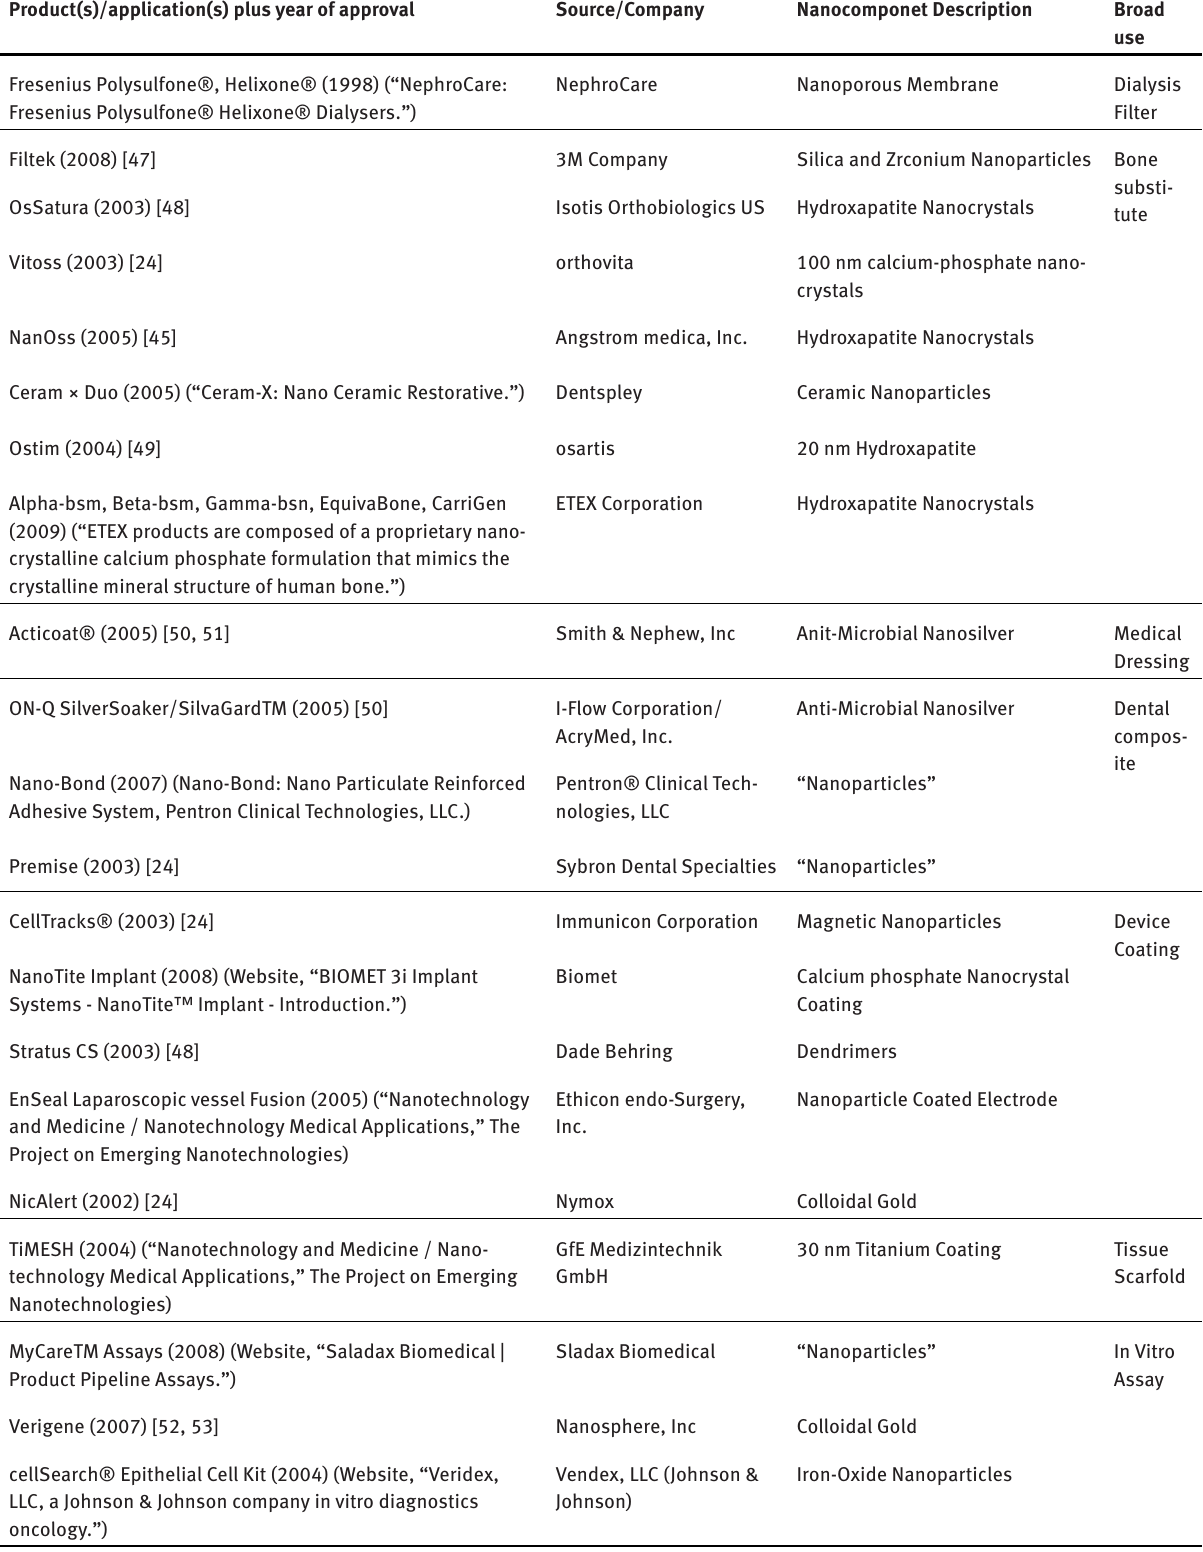
Table 2: Nano-products approved for use, with